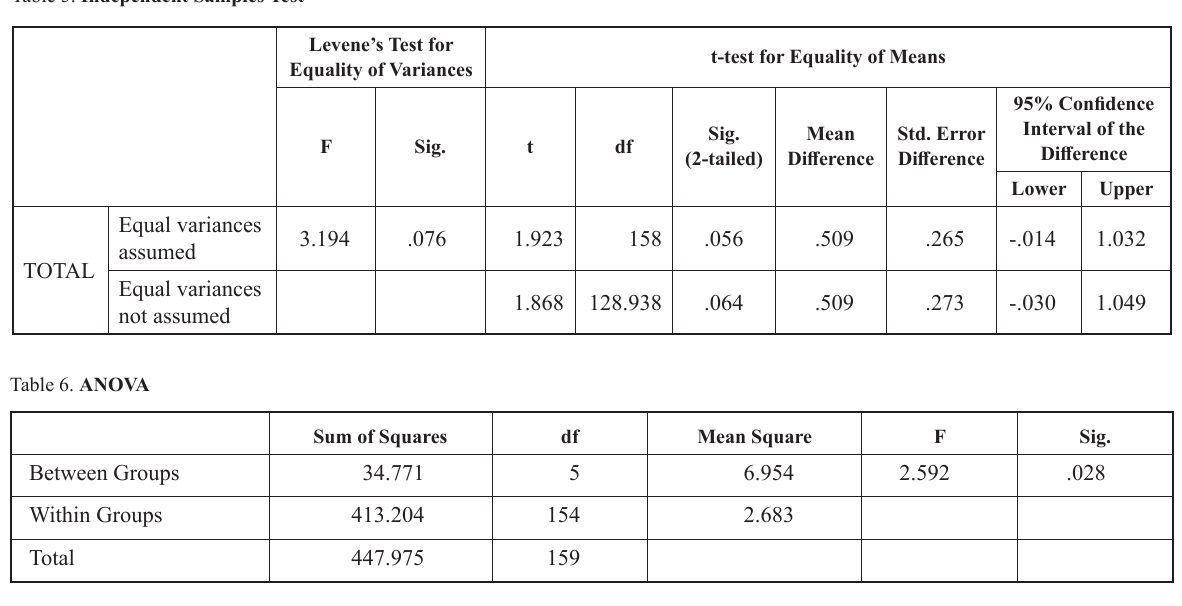
Table 5. Independent Samples Test